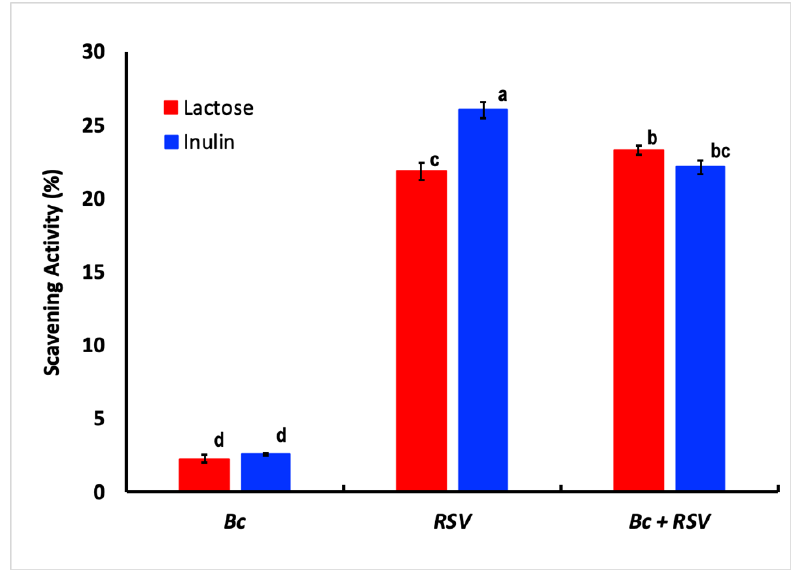
Figure 4. Effect of the microencapsulation of B. clausii ( Bc ), resveratrol (RSV) and Co- Figure 4. E ff ect of the microencapsulation of B. clausii ( Bc ), resveratrol (RSV) and Co-microencapsulation microencapsulation of ( Bc + RSV) processes on the scavenging activity of spray dried powders at of ( Bc + RSV) processes on the scavenging activity of spray dried powders at concentration of 15 mg / concentration of 15 mg/mL. a, b, bc, c and d are the parameters of the Tukey’s HSD test.